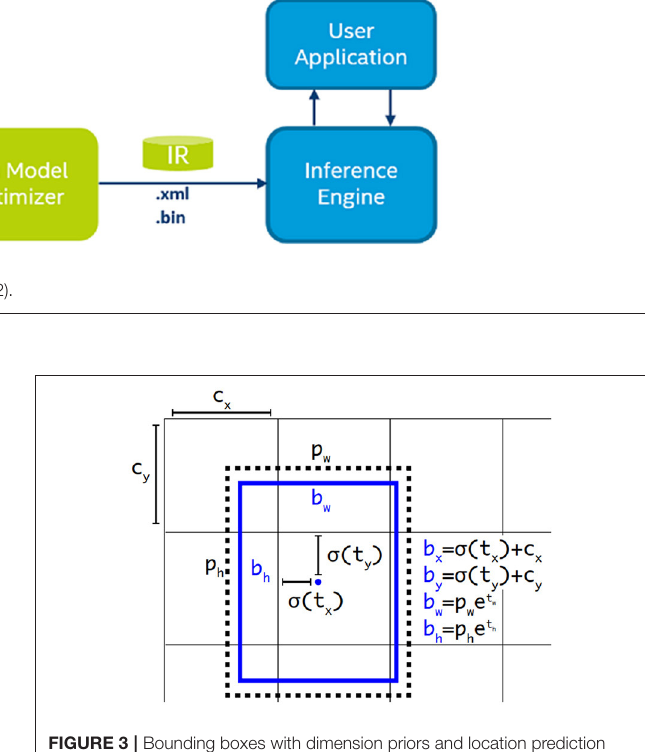
FIGURE 3 | Bounding boxes with dimension priors and location prediction for